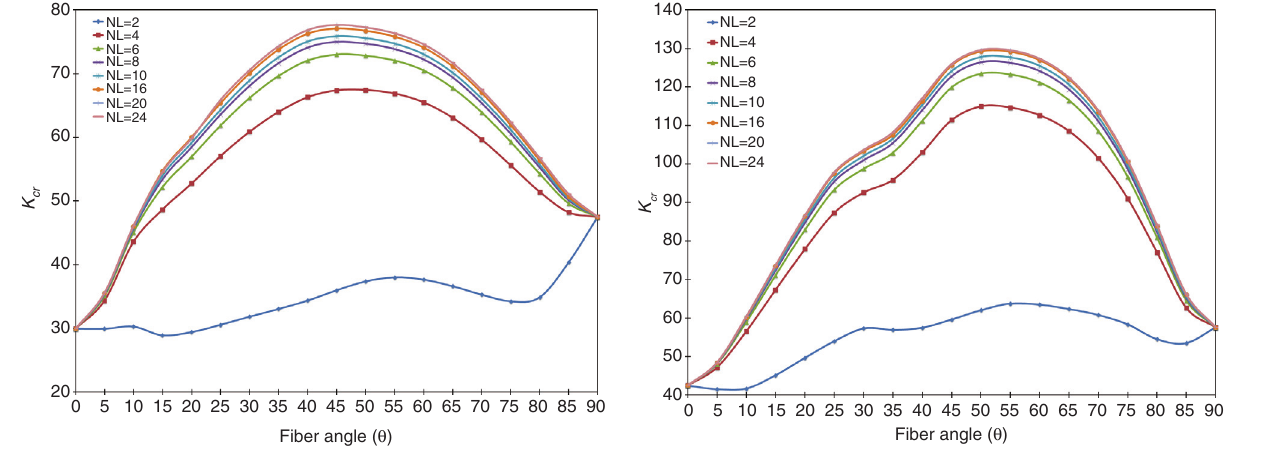
Figure 3 Critical buckling load parameter for simply supported antisymmetric cylindrical skew panel (Ø = 15 ° , α = 0 ° ).